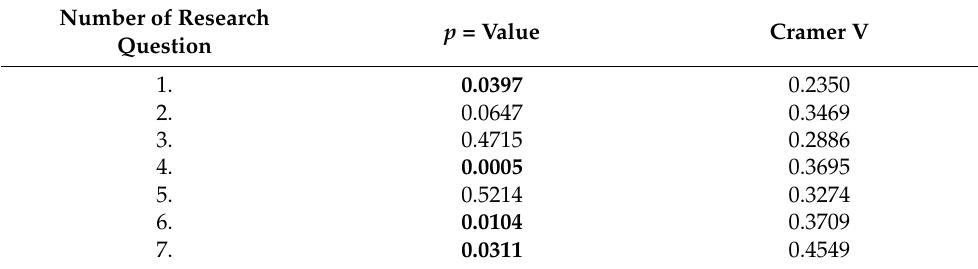
Table 1. Values from the statistical analysis (values: p -value < 0.05 and Cramer V).